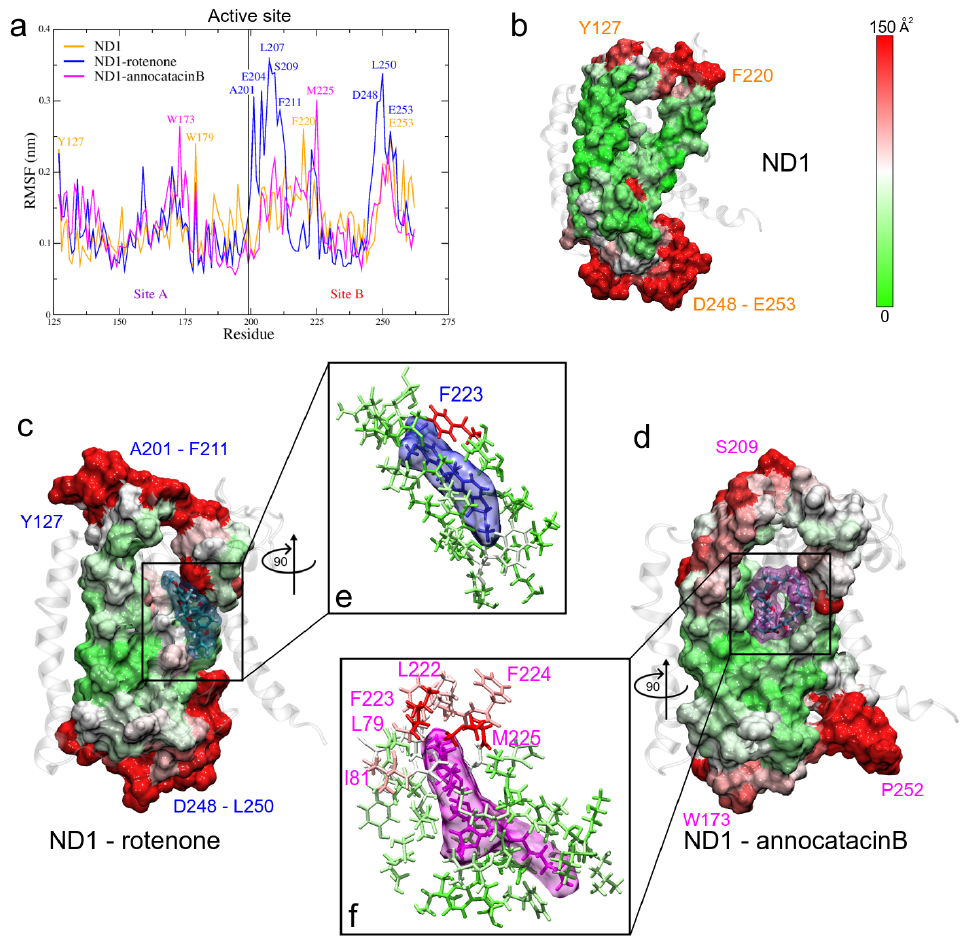
Figure 7. Fluctuation analysis of the ND1 residues. ( a ) RMSF plot of the active site residues obtained during the last 200 ns of the MD trajectories. ( b – d ) B-factor plotted on the molecular surface of the active site. The red color indicates high B factor values, whereas the green, low values. Ligands are shown in translucid surface, rotenone in blue color, and annocatacin B in magenta color. ( e , f ) Zoom of the ligand